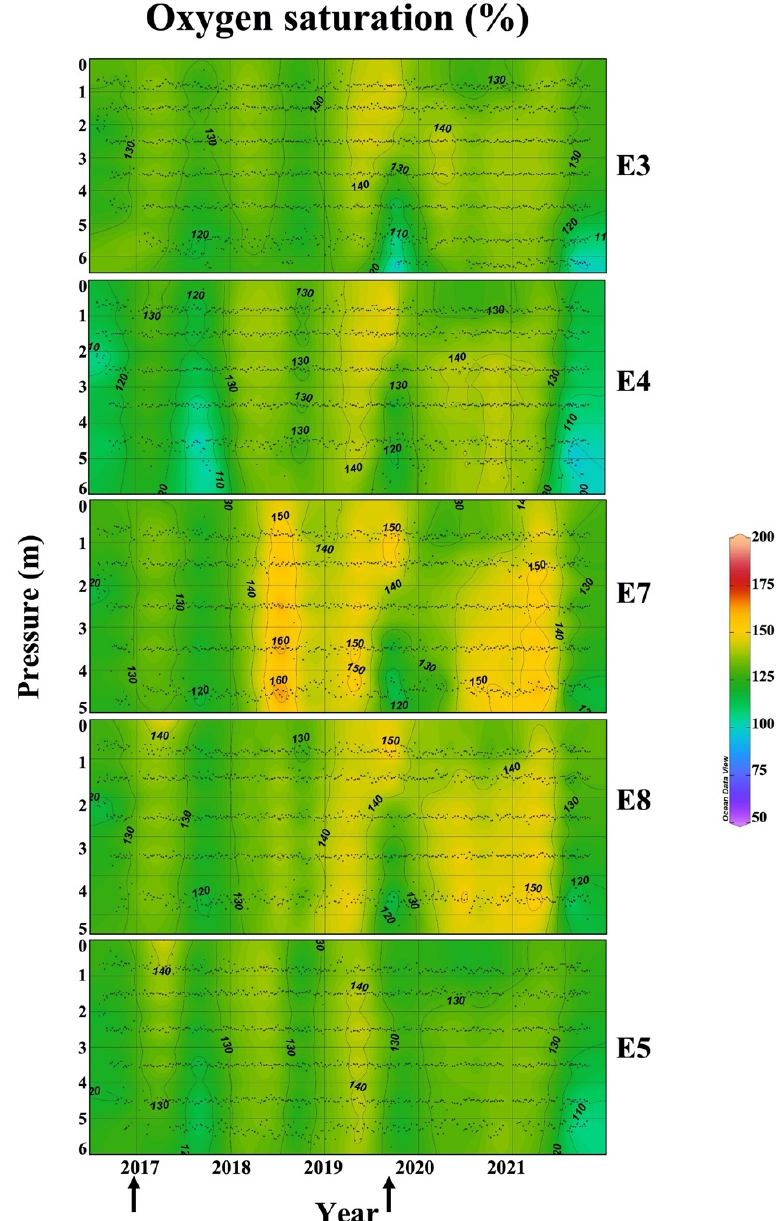
Figure 5. Temporal evolution of oxygen saturation at stations E3, E4, E7, E8, and E5 from August 2016 to October 2021. The vertical arrows indicate when the two DANA events occurred (December 2016 and September 2019, respectively).